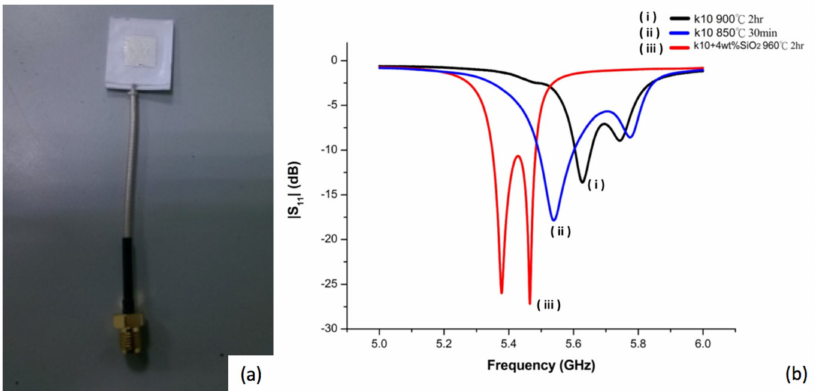
Figure 1. ( a ) Image showing fabricated microstrip antenna and ( b ) reflection coefficients for two different low temperature co-fired ceramic (LTCC) processing conditions of diopside glass-ceramics and for a modified diopside glass-ceramic